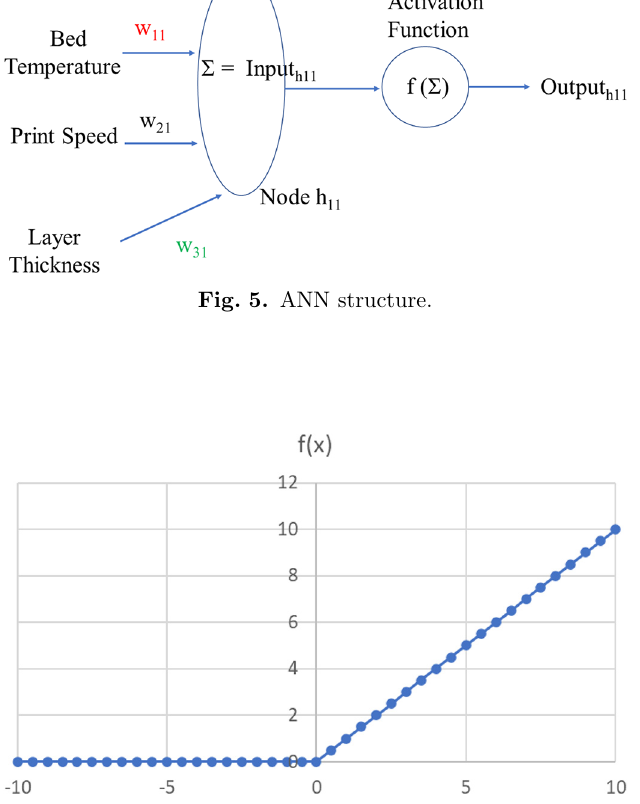
Fig. 6. Graphical representation of activation function